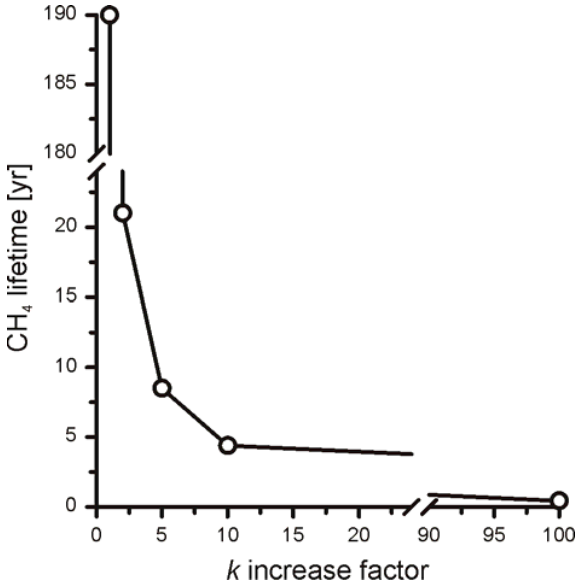
Fig. 5. Lifetime of methane perturbation as a function of the in- crease factor of k . Model runs were performed for factors of 2, 5, 10, and 100. The results of box 6 are displayed from simulations with Model